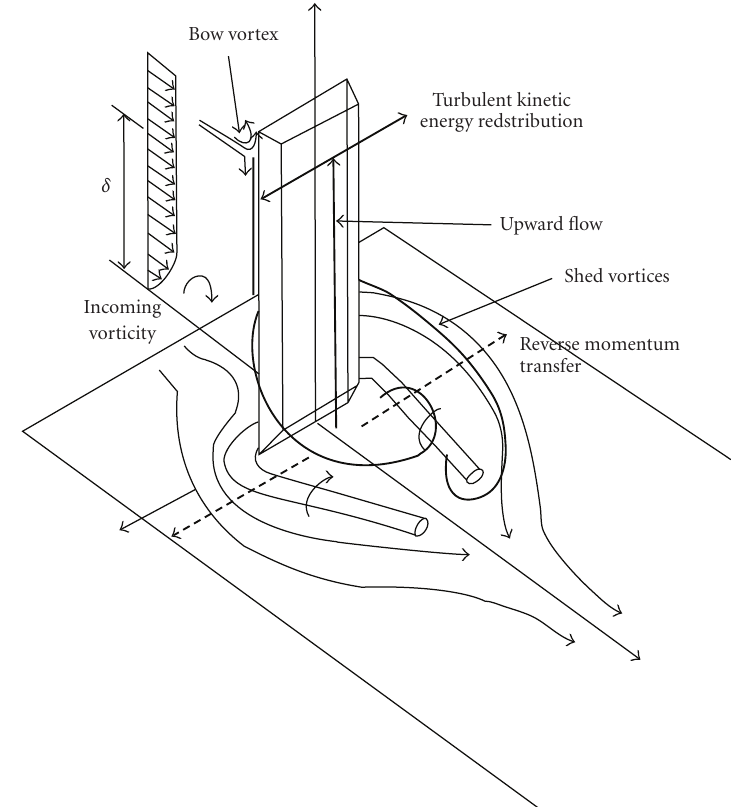
Figure 4: A simple model of the shallow wake, as constructed from the available literature.